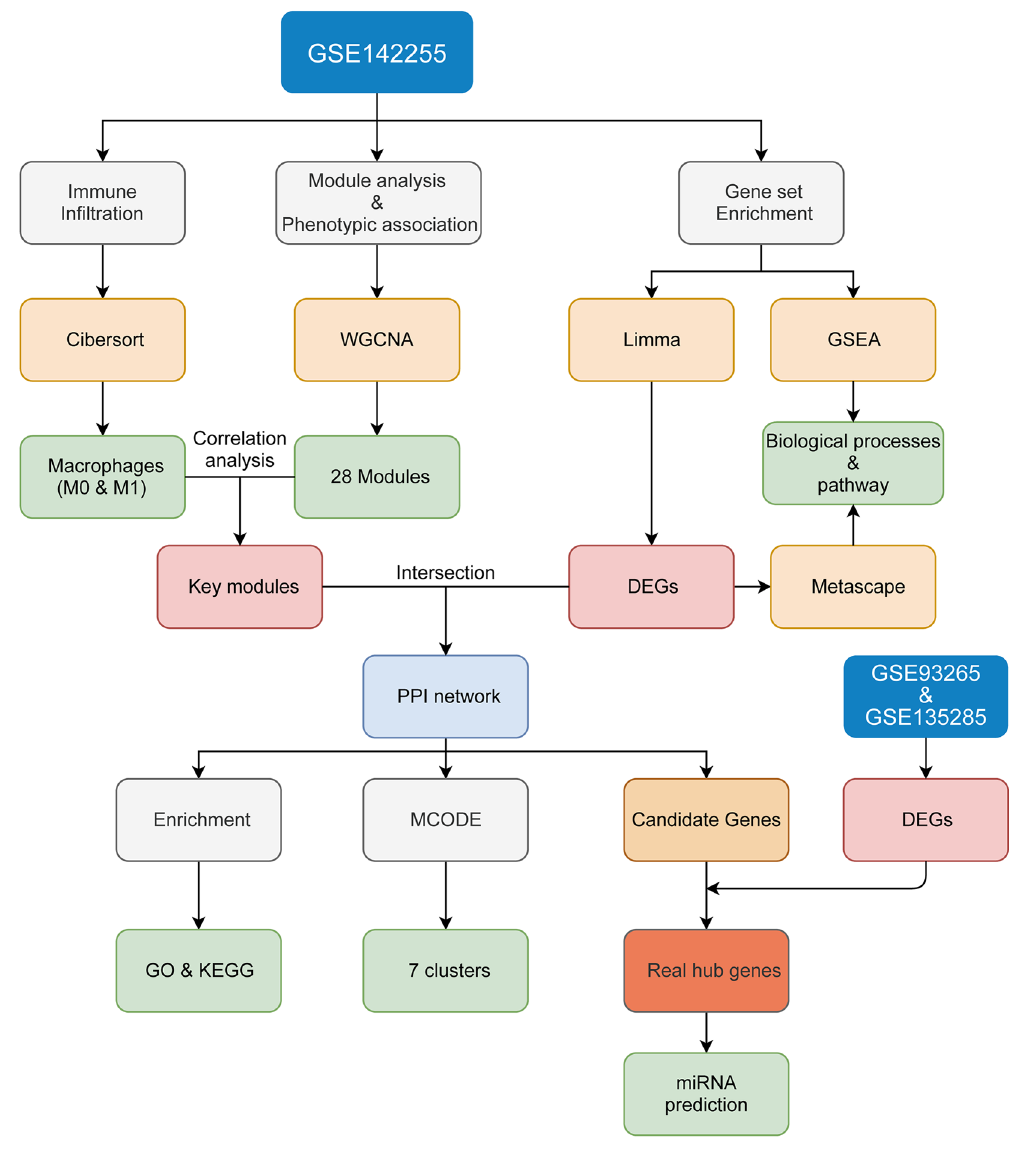
Figure 1. Flow chart of bioinformatics analyses for ACLF.